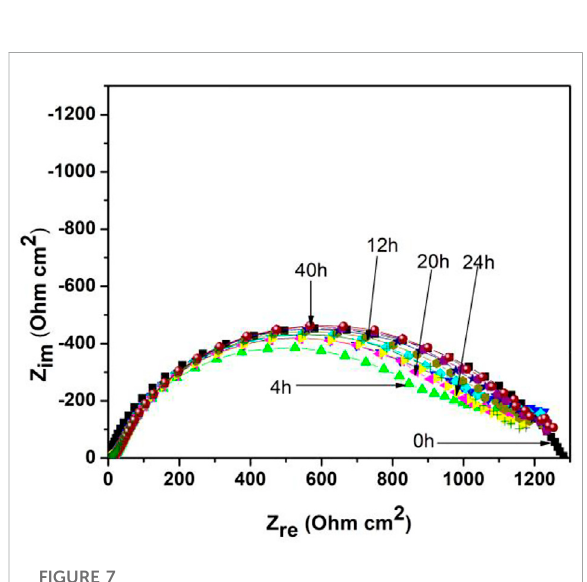
FIGURE 7 Nyquist diagrams at different exposure times of 1018 steel in acid media with 500 ppm of M. sativa and the addition of 5 mM KI at 25 ± 2 °